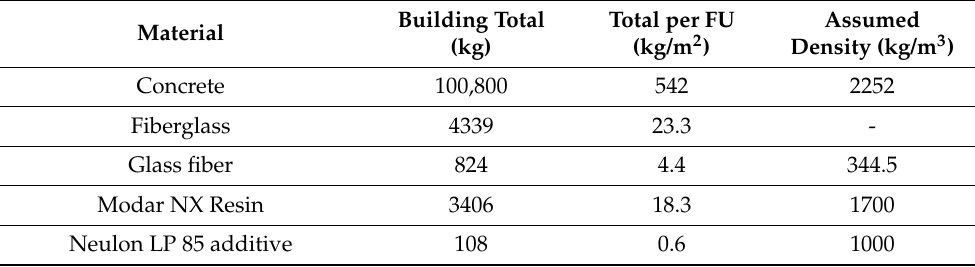
Table 3. Estimated quantity (in kg) of each main material for the total building and to meet the functional unit. Includes the assumed density used to calculate the weight for relevant